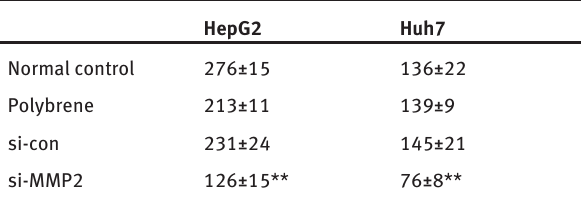
Table 1: Invasive cell counts of HepG2 and Huh7 cells after lentivi- rus-mediated transduction (at 48 h and 72 h, respectively) based on Transwell